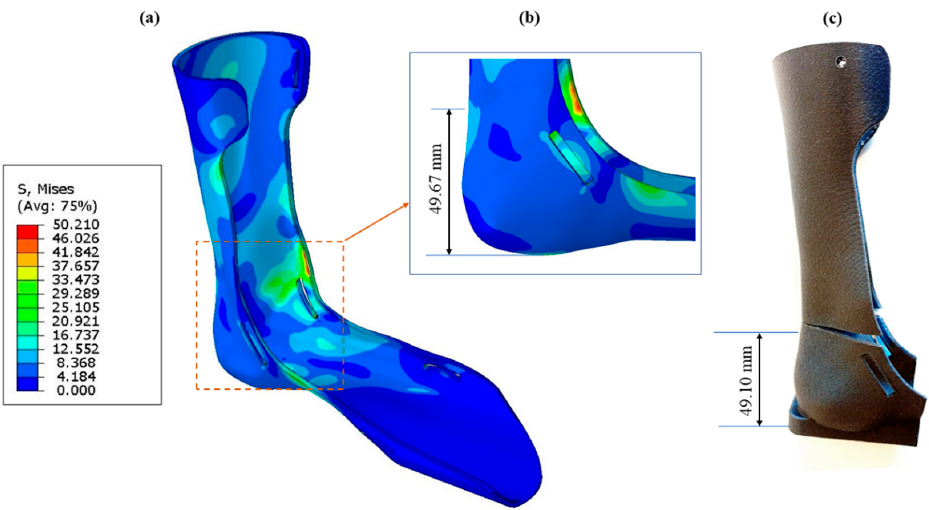
Figure 9. Force–displacement curves for both PLA- and PLA-C-based AFOs until fracture.